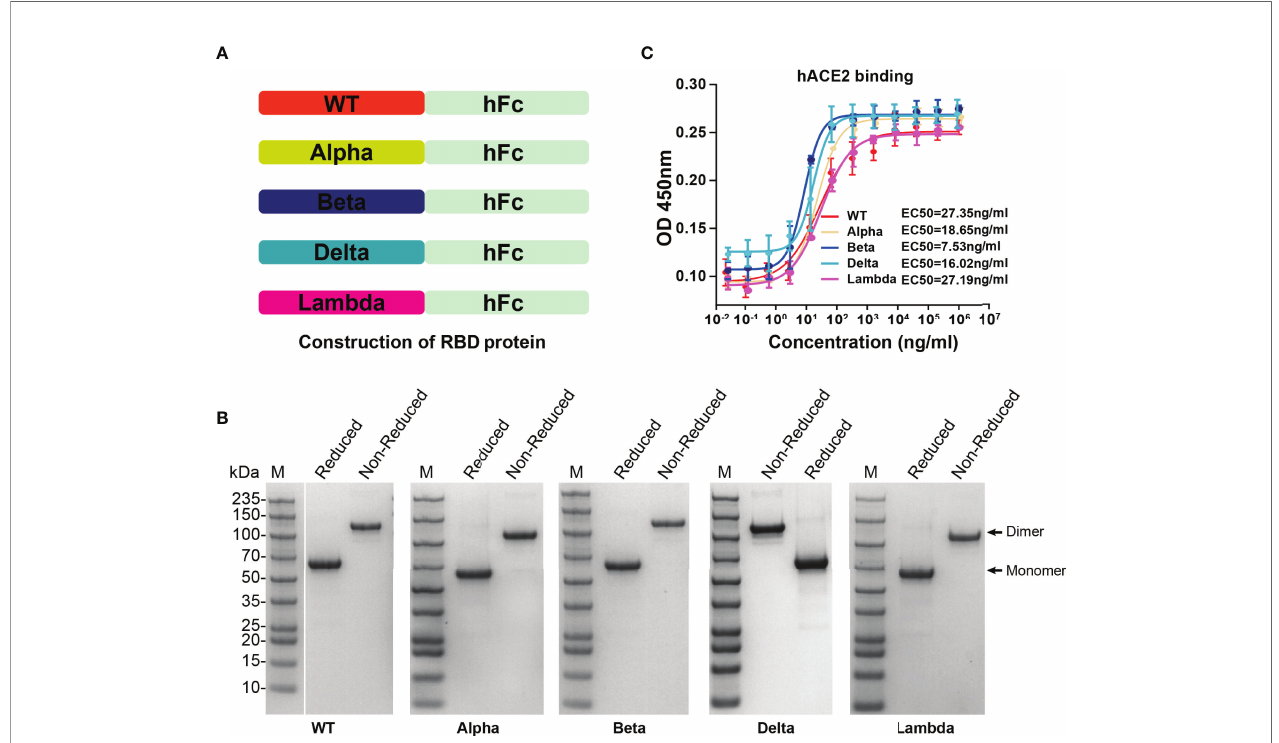
FIGURE 2 | The expression of SARS-CoV-2 variant RBD proteins and determination of af fi nity between variant RBD and hACE2. (A) The construction strategy of WT and variant RBD proteins. The RBD proteins were expressed in HEK293T cells by fusion of human IgG Fc tag in the form of secretion. (B) SDS-PAGE gel images of puri fi ed RBD proteins. (C) The ability of different variant RBDs to bind to hACE2 was test by ELISA. ELISA plate was coated with hACE2 protein (2 m g/ml). The fi tted curves and half maximal effective concentration (EC50) were created using Graphpad software (version